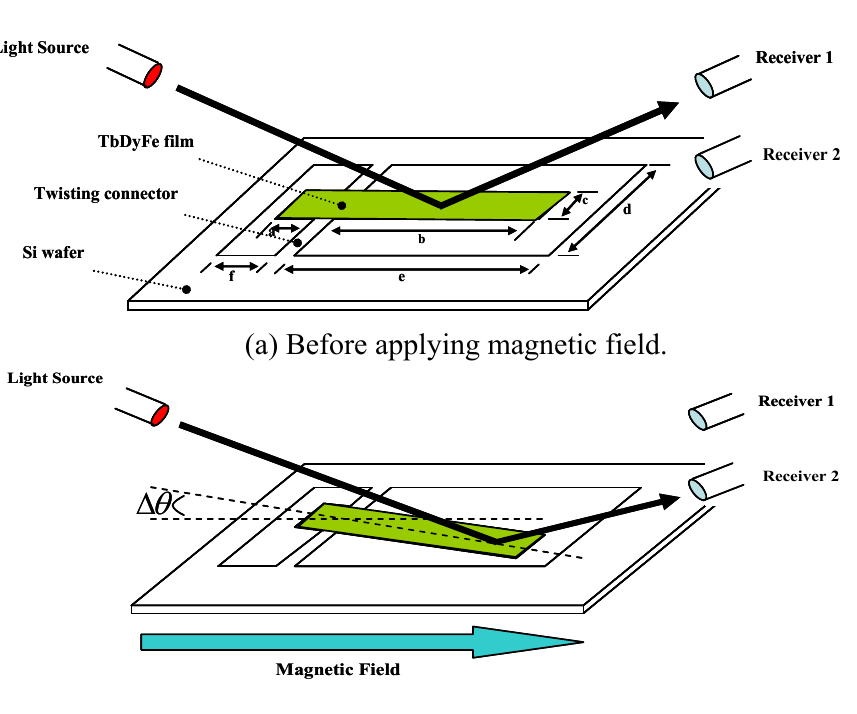
Figure 1. Schematic models of magnetostrictive optical switch